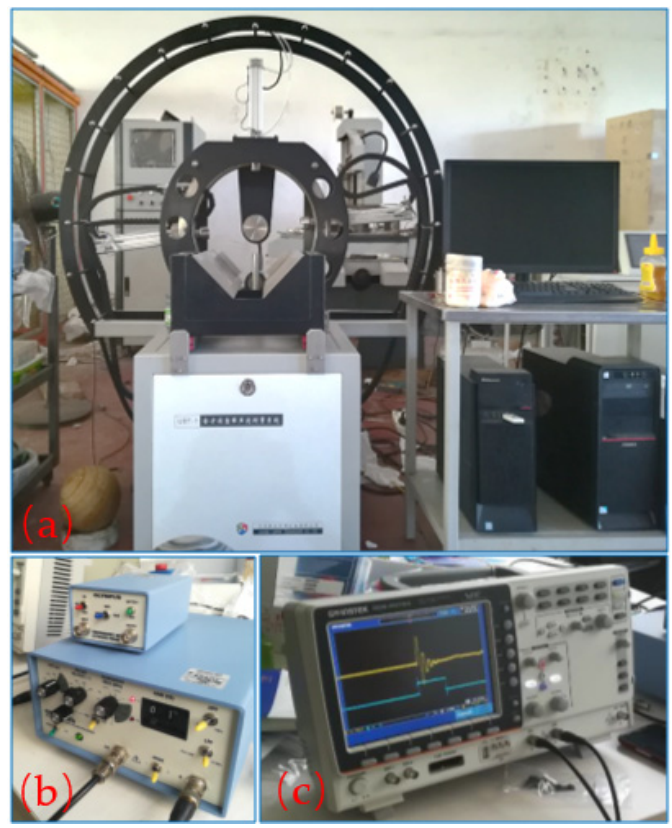
Figure 2. Actual picture of the three-dimensional anisotropic measurement device: ( a ) omnidirec- tional positioning system, ( b ) signal generator and amplifier, and ( c ) oscillograph.